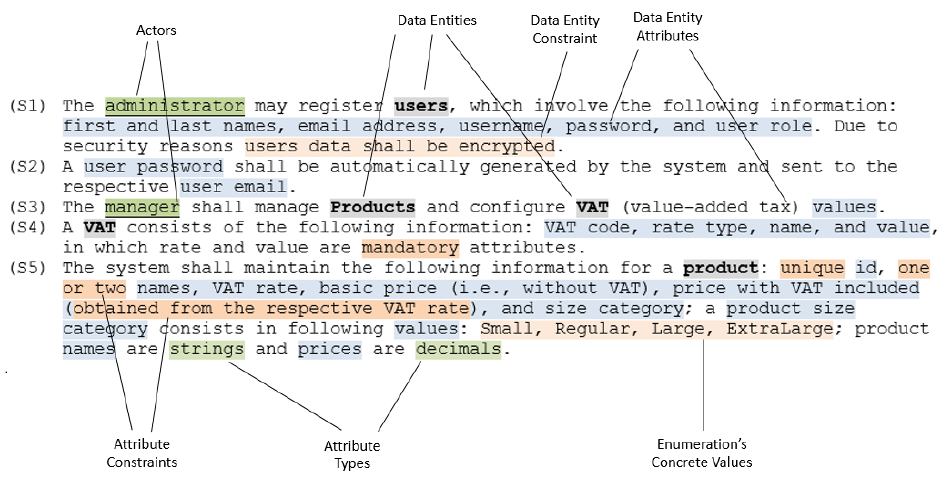
Figure 1. Example of informal requirements with data entities and other related elements.